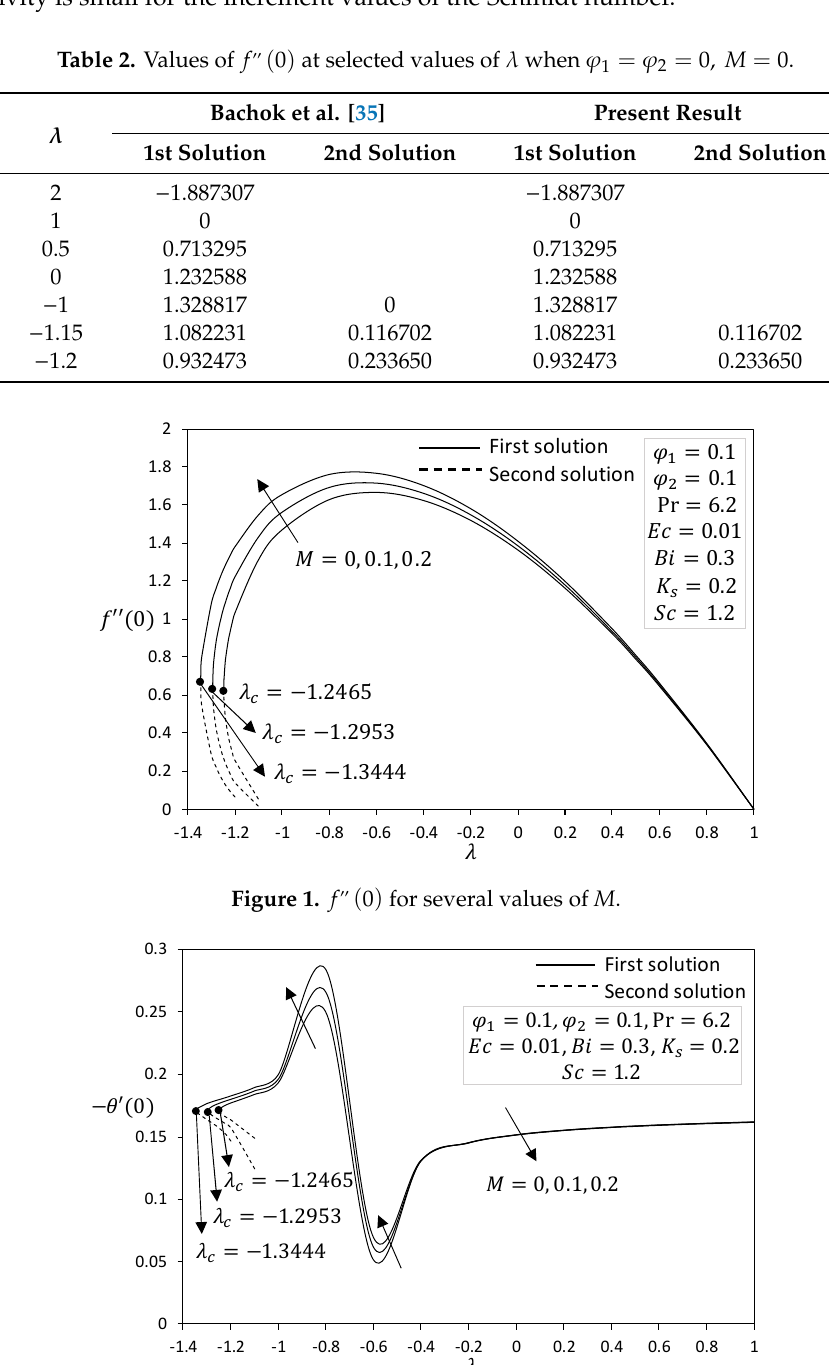
Figure 2. − θ (cid:48) ( 0 ) for several values of M ( ) 0 θ′− for several values of M . Figure 2.